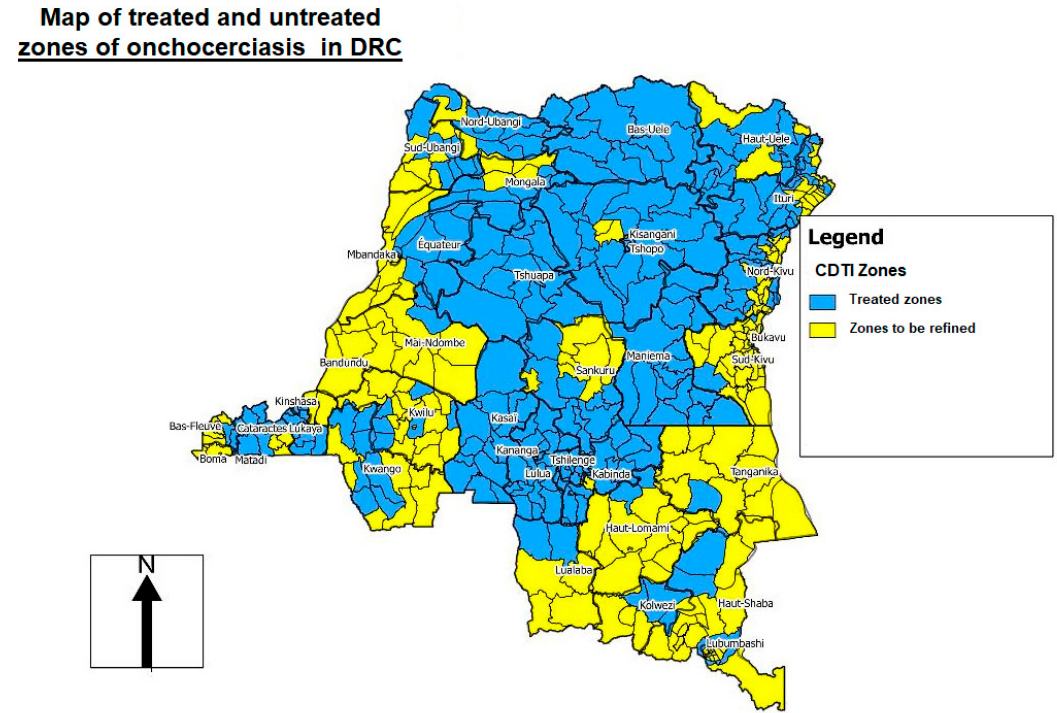
Figure 2. Rapid epidemiological mapping of onchocerciasis (REMO) in the Democratic Republic of the Congo (DRC), showing areas (in blue) where community-directed treatment with ivermectin (CDTI) is needed 2019 [22].